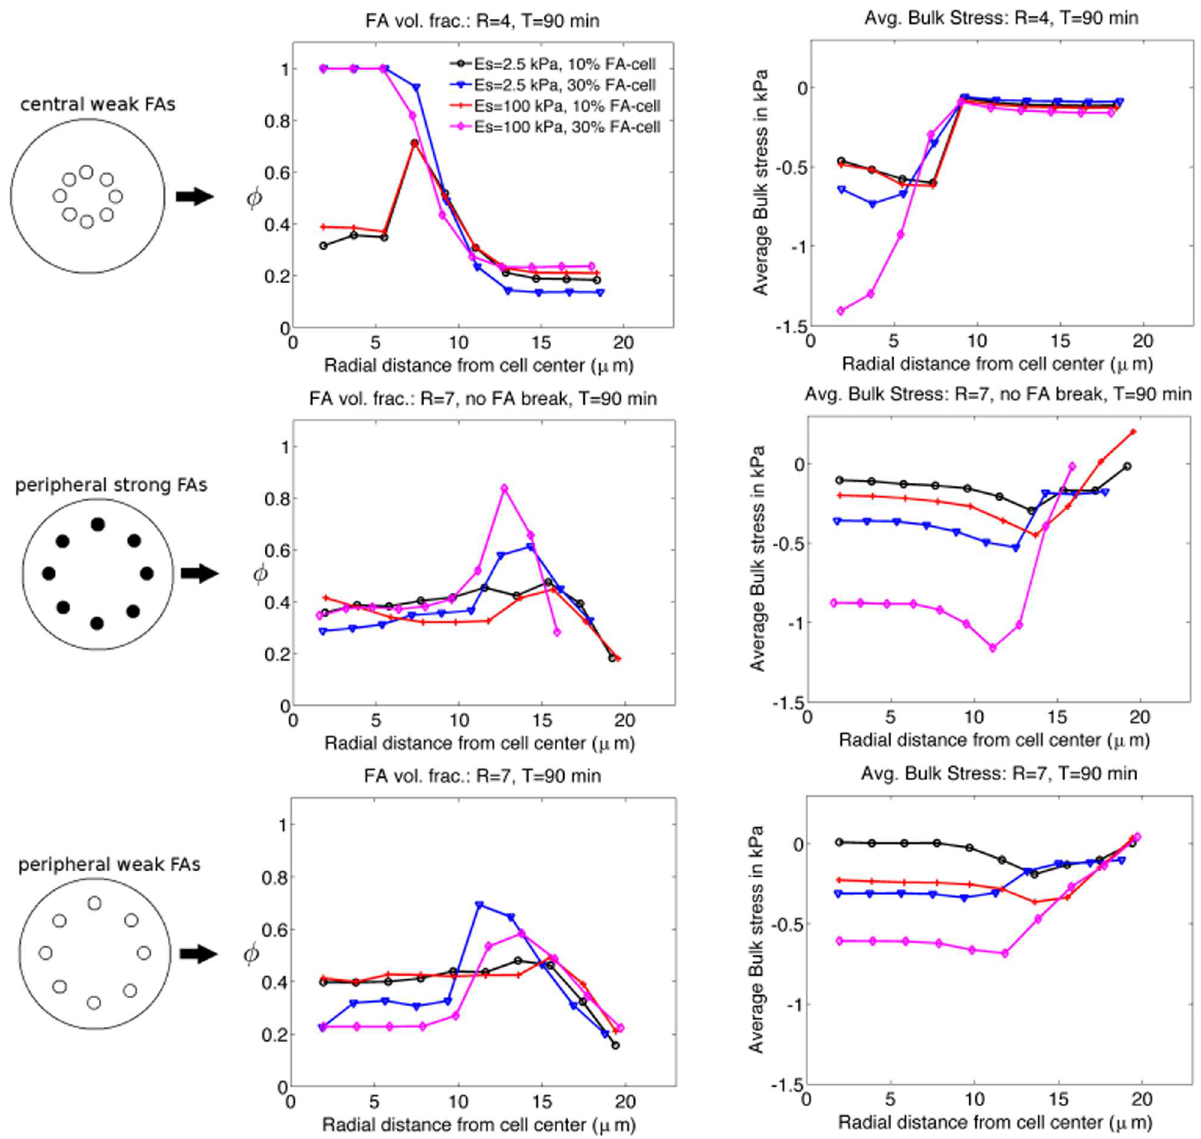
Fig 7. Dependence of FA volume fraction ϕ and bulk stress on spread cell radius. We considerfour different substrate Young’s modulus,FA-cell area ratio combinations: black- E s = 2.5 kPa, 10%, blue- E s = 2.5 kPa, 30%, red- E s = 100 kPa, 10%, magenta- E s = 100 kPa, 30%. A legendfor all graphs is in the top left panel, and the initial FA configurationsfor data illustratedin a given row are shown in the left-most